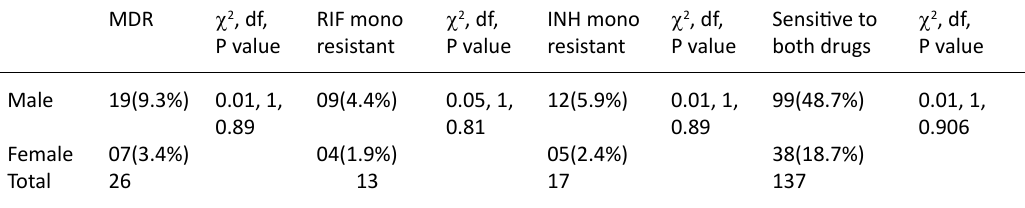
Table 3. Sex wise distribution pattern among different drug resistant cases